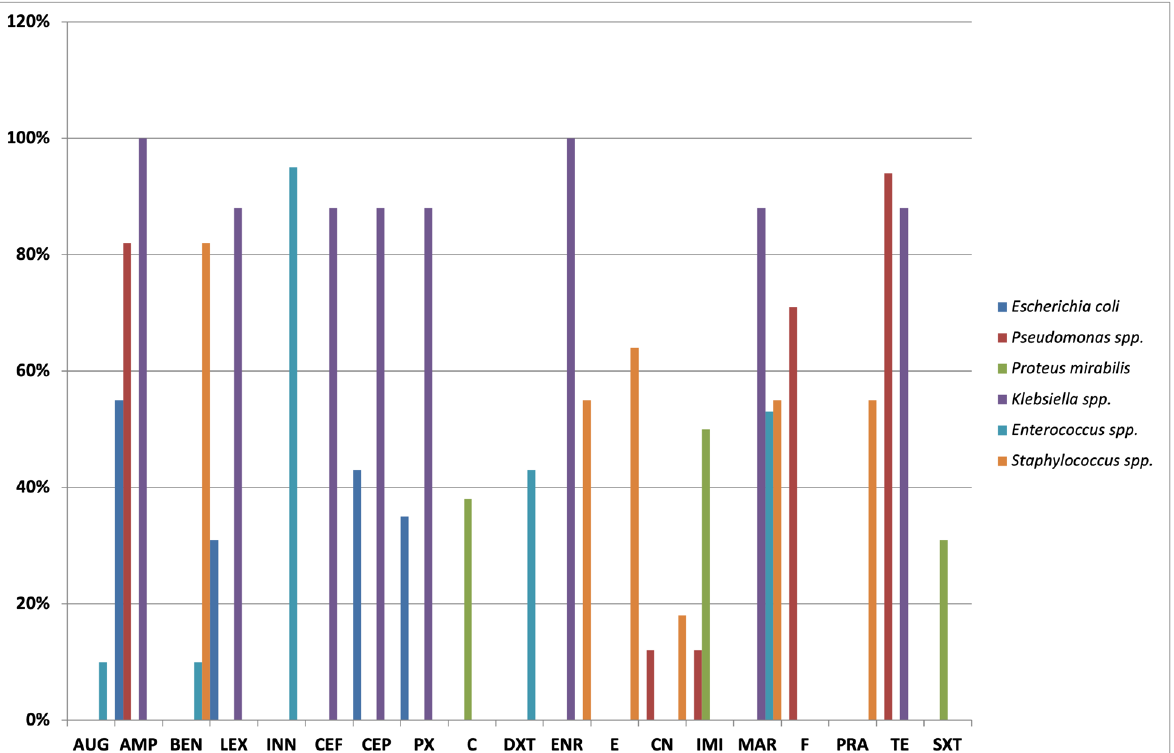
Figure 2. Antimicrobial resistance frequencies (% of resistant bacteria) detected in isolates from urine samples of cats. The percentage values greater than or equal to 10% are reported. AUG: